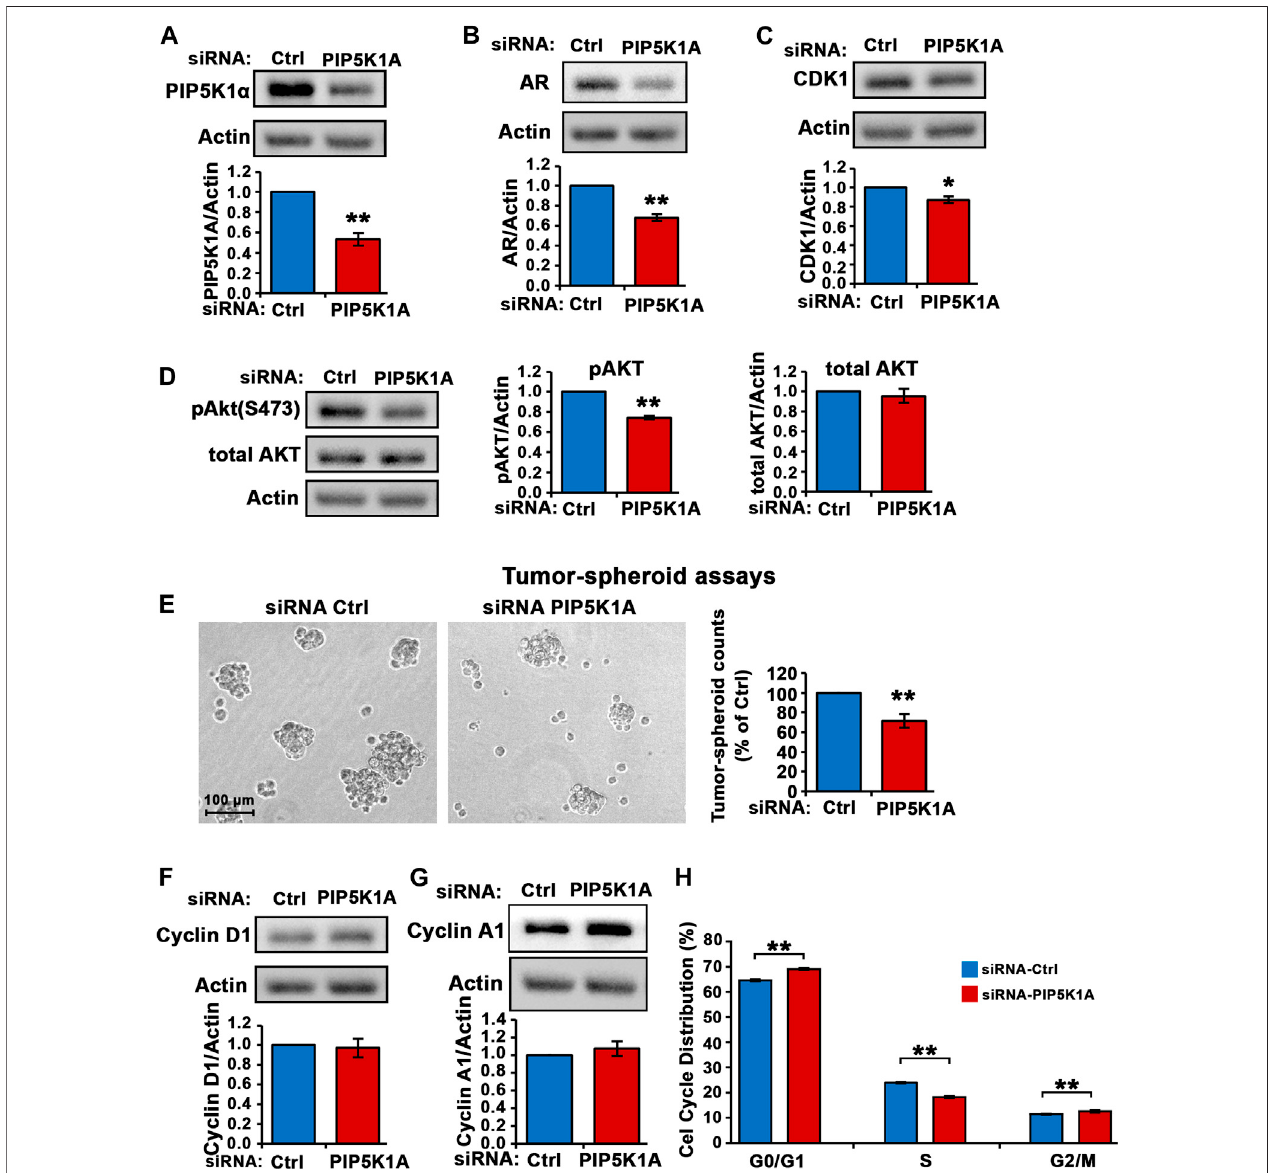
FIGURE2 | The effect ofPIP5K1 α inhibitionon PIP5K1 α -associated pathways in DU145 cells. (A) PIP5K1 α was silenced by transfecting DU145 cells withcontrol- siRNA (Ctrl-siRNA) or PIP5K1A-siRNA. Immunoblot analysis of PIP5K1 α expression in Ctrl-siRNA or PIP5K1A-siRNA transfected cells is shown. Quanti fi cations of the immunoblots for PIP5K1 α expression are shown in the below panel. (B,C) Immunoblot analysis on the expression of AR and CDK1 in Ctrl-siRNA or PIP5K1A-siRNA transfected cells is shown. Quanti fi cations of the immunoblots for AR and CDK1 expression are shown in the below panel. (D) Immunoblot analysis on the expression of pSer-473 AKT and total AKT in Ctrl-siRNA or PIP5K1A-siRNA transfected cells is shown. Quanti fi cations of the immunoblots for pSer-473 AKT and total AKTexpressionareshownintherightpanels. (E) ThetumorspheroidsderivedfromDU145cellstransfectedwithCtrl-siRNAorPIP5K1A-siRNA.Representativeimages of tumor spheroids taken under the microscope are shown in the left panel. The quanti fi cation of the counts of tumor spheroids from each group is shown in the right panel. (F,G) Immunoblot analysis on the expression of cyclin D1 and cyclin A1 in Ctrl-siRNA or PIP5K1A-siRNA transfected cells is shown. Quanti fi cations of the immunoblotsforcyclinD1and cyclinA1expression areshown inthebelowpanels. (H) CellcycledistributionsofCtrl-siRNA orPIP5K1A-siRNAtransfectedDU145 cells were analysed by fl ow cytometry. Different cell cycle phases: G0/G1, S and G2/M are indicated. Data in this fi gure is presented as the average of three independent experiments (±SE). Student ’ s t -test was used in the analysis. * p < 0.05 or ** p < 0.01 are indicated.